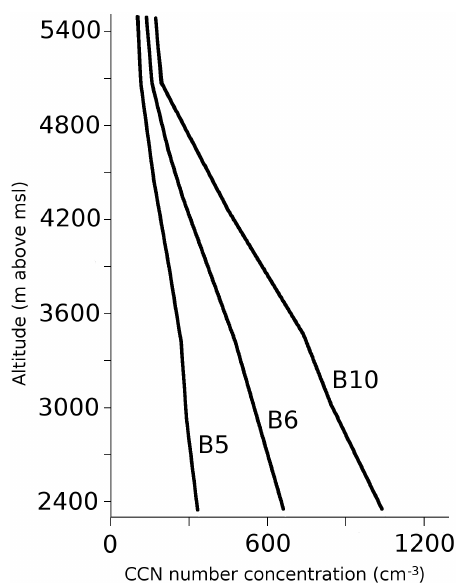
Fig. 5. Vertical profiles of CCN diagnosed from RAMS simula- tions B5, B6, and B10 for conditions of 0.6% supersaturation and T =25 ◦ C. The profiles were taken from 40.5 ◦ N and 107.0 ◦ W at 30 simulation minutes after the model